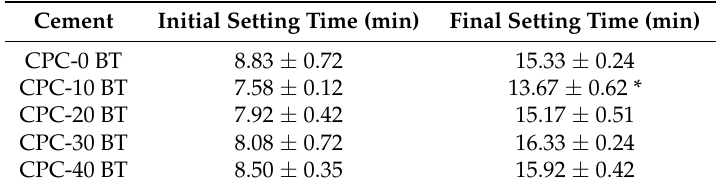
Table 4. Setting time for smart CPCs with various wt % barium titanate